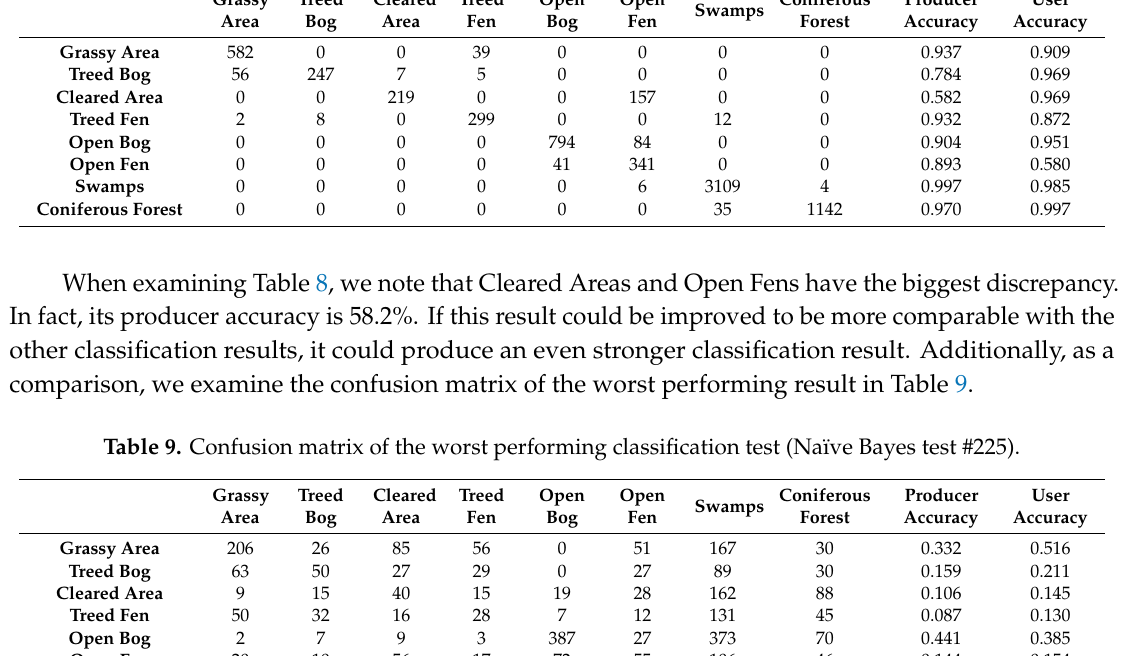
Table 8. Confusion matrix of the best performing classification test (RF test #77). Grassy Area